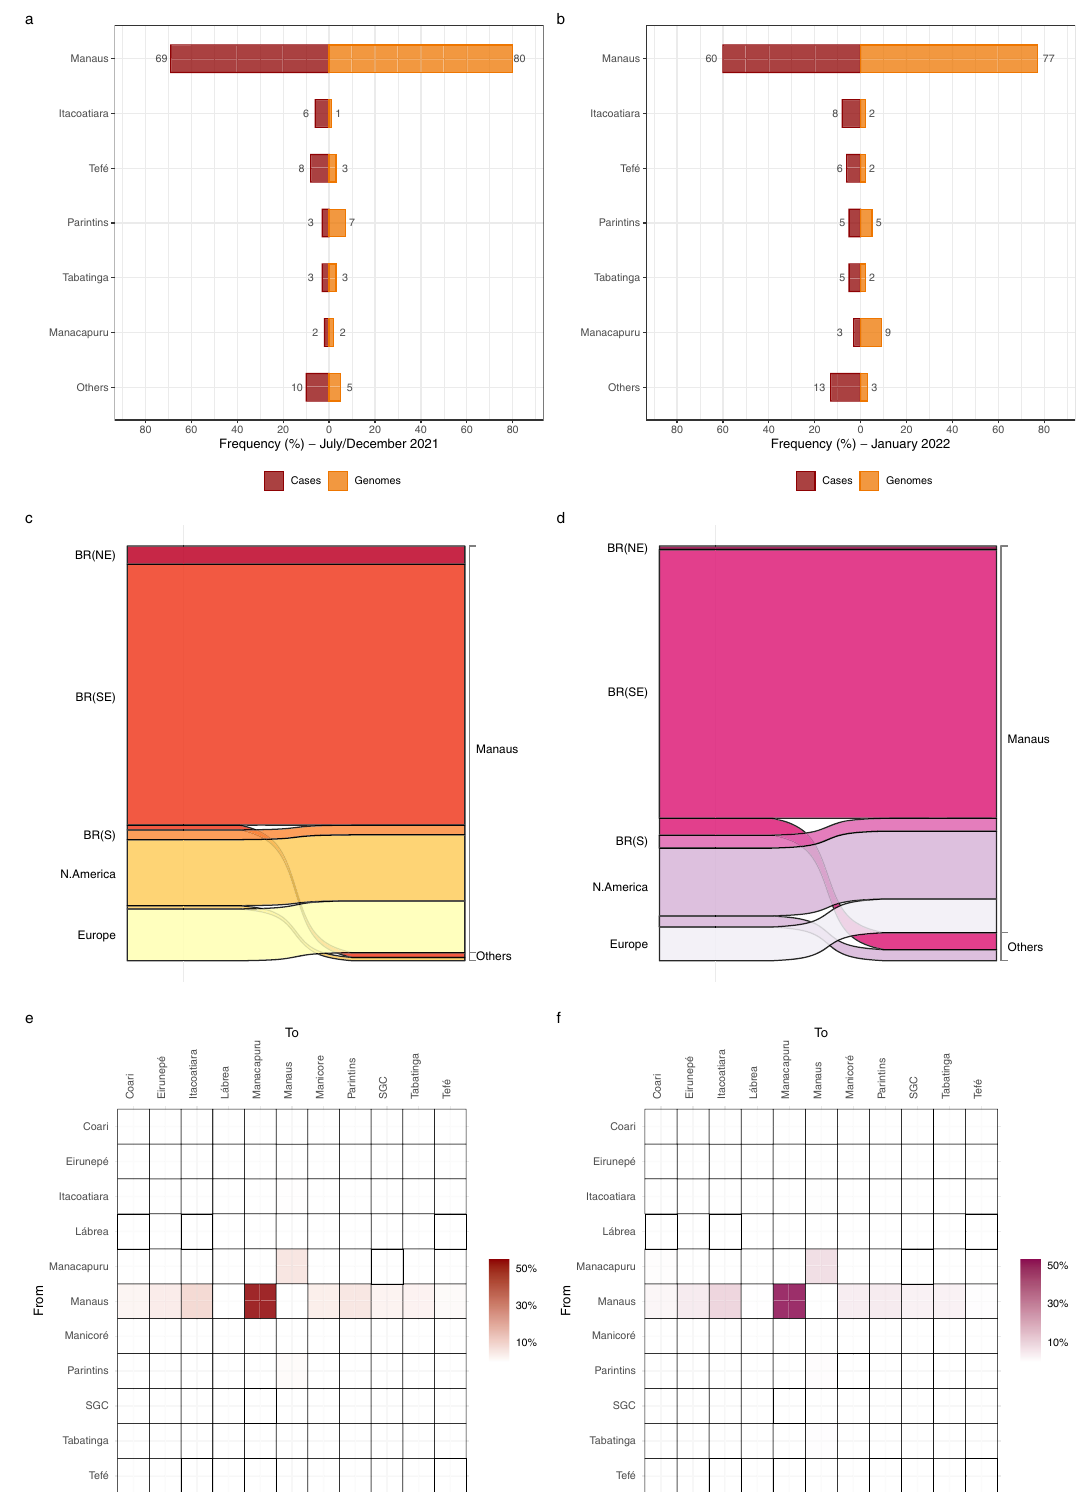
Fig. 5 | Sampling bias and phylogeographic inferences. a , b Geographic dis- tribution of SARS-CoV-2 con fi rmed cases and SARS-CoV-2 genomes from different Amazonian regions during the period of Gamma/Delta (Jul – Dec 2021) ( a ) and OmicronBA.1(Jan2022)( b ). c , d Alluvialplotsre fl ectthetotalestimatednumberof BA.1 lineage imports from each source location (left side) into Manaus or other municipalities (right side), inferred from the Bayesian phylogeographic analyses